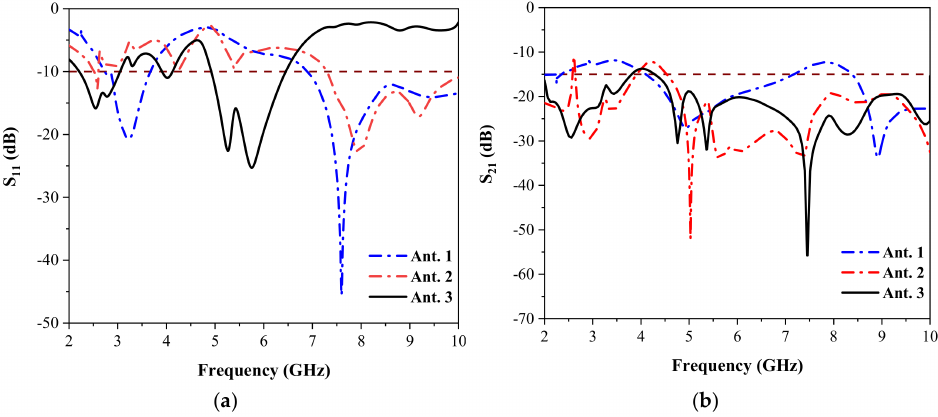
Figure 1. Structure of the designed MIMO antenna. ( a ) antenna 1, ( b ) antenna 2 and ( c ) antenna 3 (proposed).